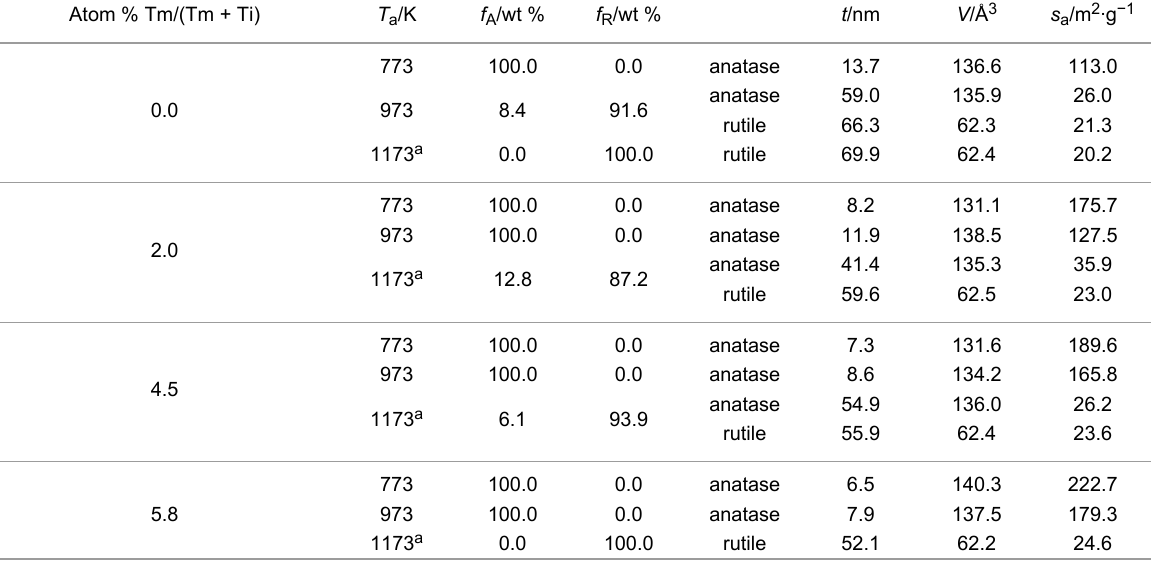
Table 2: Semiquantitative values of anatase and rutile mass fraction, average crystallite size, unit cell volume and specific surface area obtained from XRD patterns of the samples synthesized.